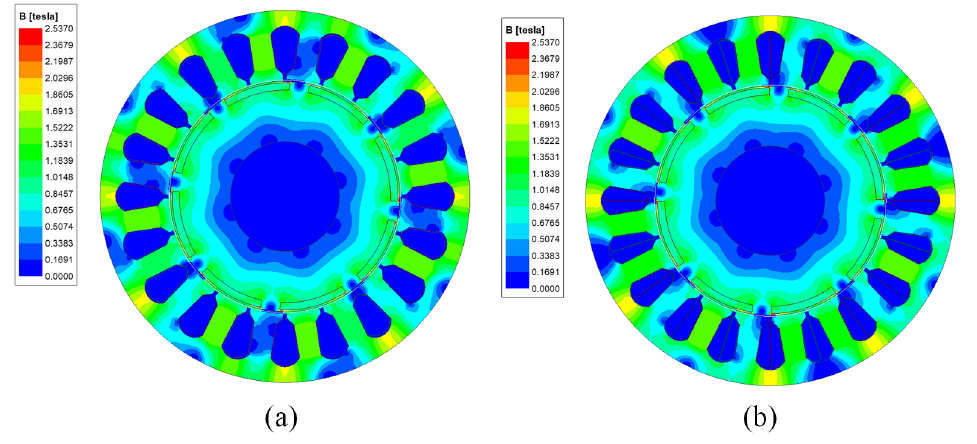
Figure 6. ( a ) Magnetic field of single-turn motor. ( b ) Magnetic field of double-layer motor.